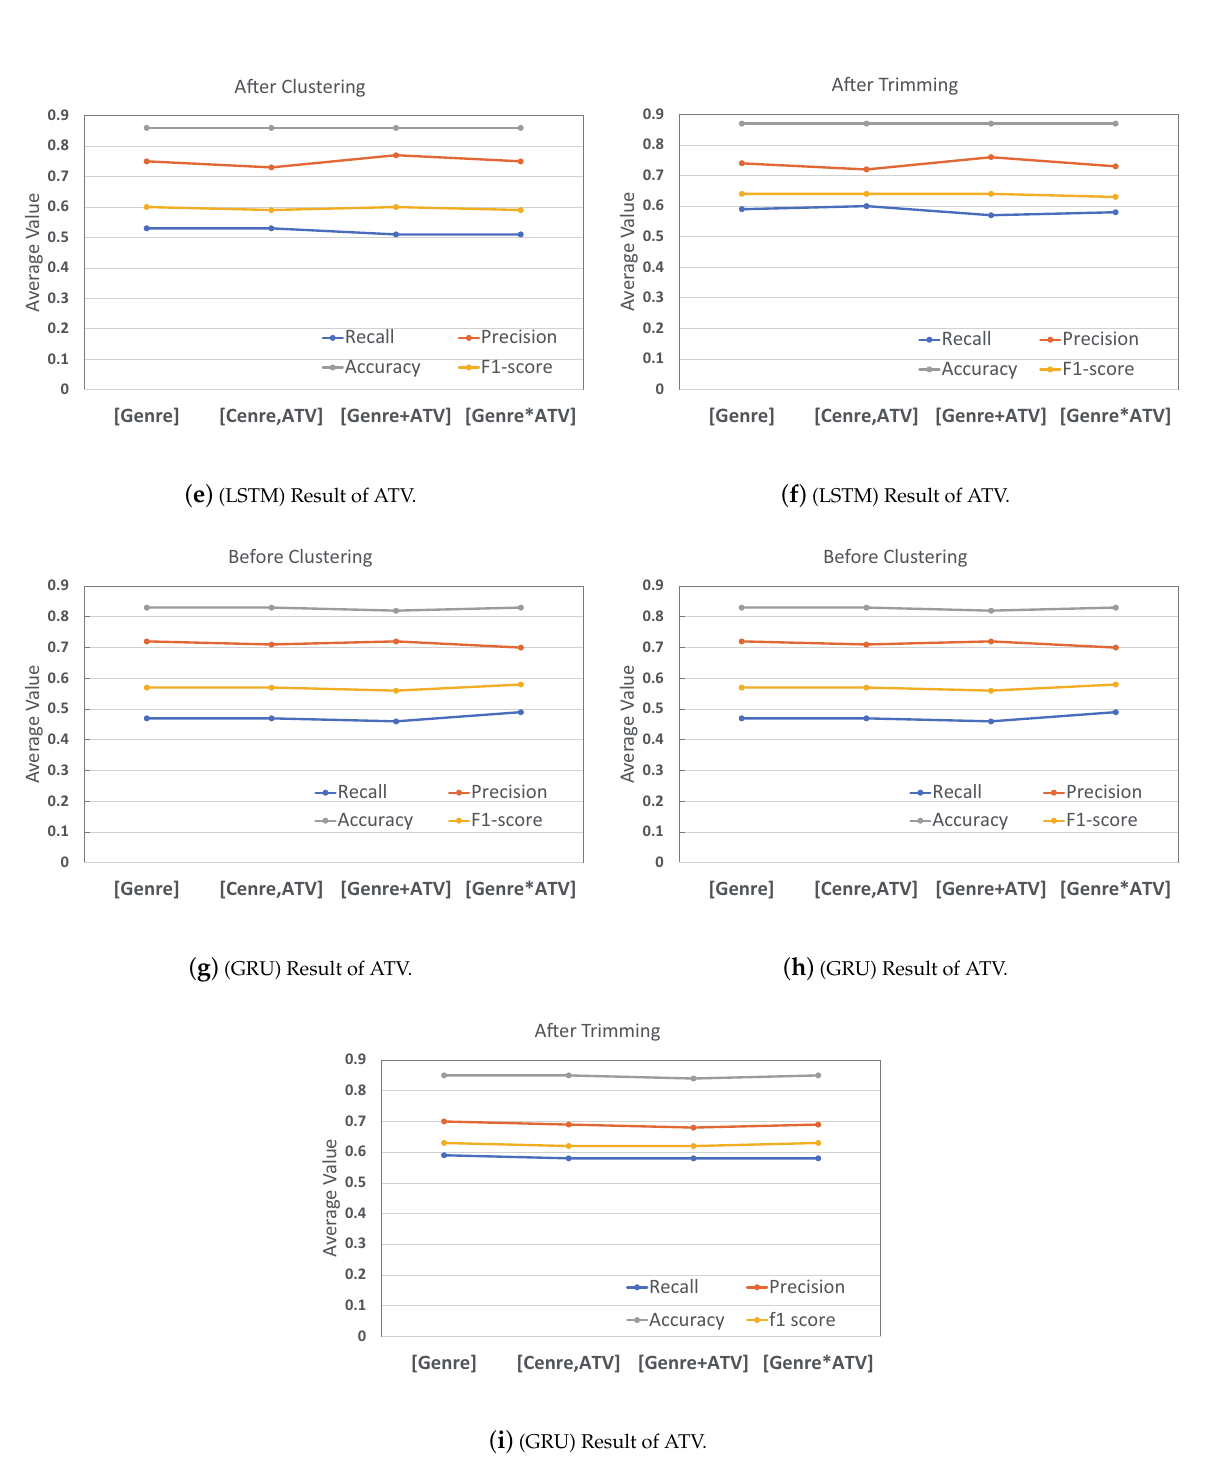
( e ) (LSTM) Result of ATV. ( f ) (LSTM) Result of ATV.